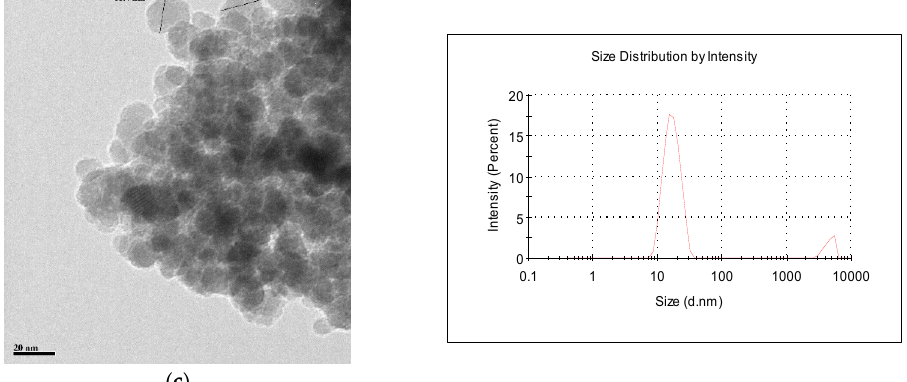
Figure 2. The TEM images and Dynamic Light Scattering (DLS) of ( a ) SPIONs, ( b ) SPIONs/gel, and ( c ) SPIONs/gel/PVA.